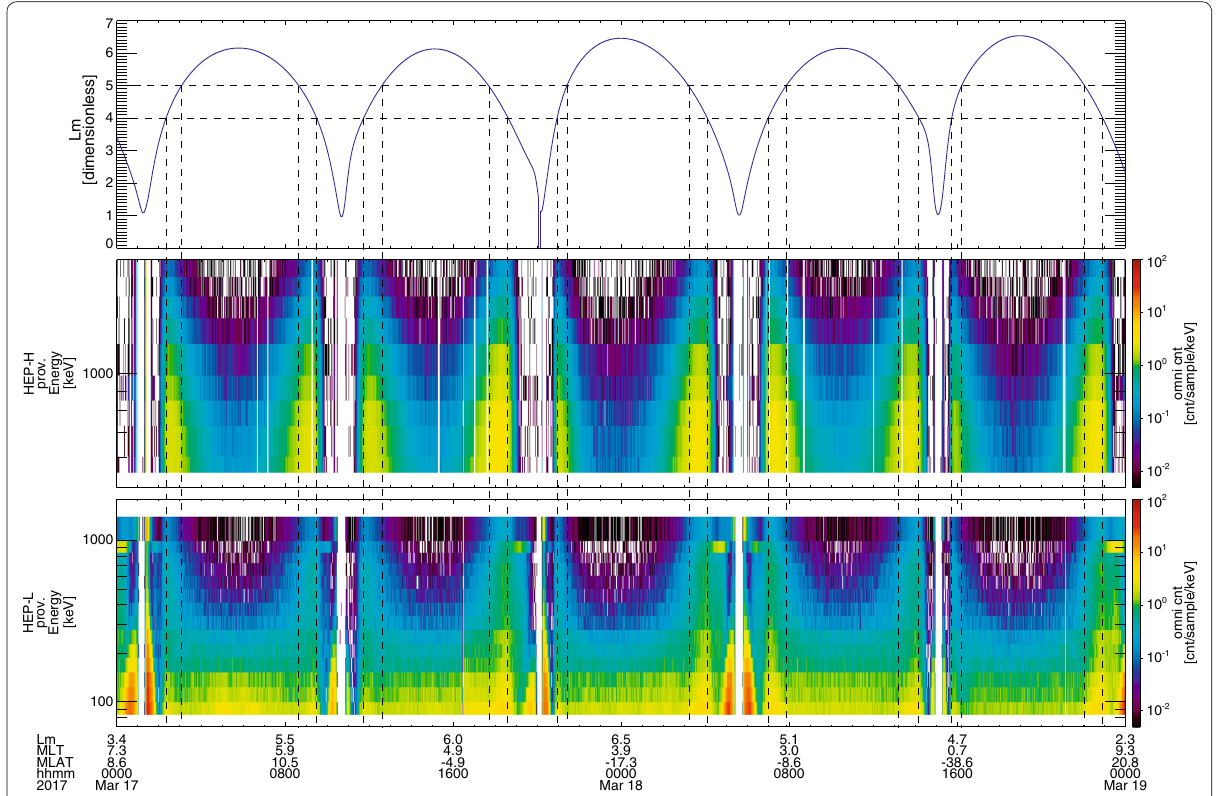
Fig. 13 Energy–time spectrograms observed via HEP flight-count data on March 17 and 18, 2017. The top panel shows L-value of ERG satellite position. Middle and bottom panels show energy–time spectrograms from HEP-L and HEP-H, respectively. Colors indicate raw count not corrected for G-factor or detection